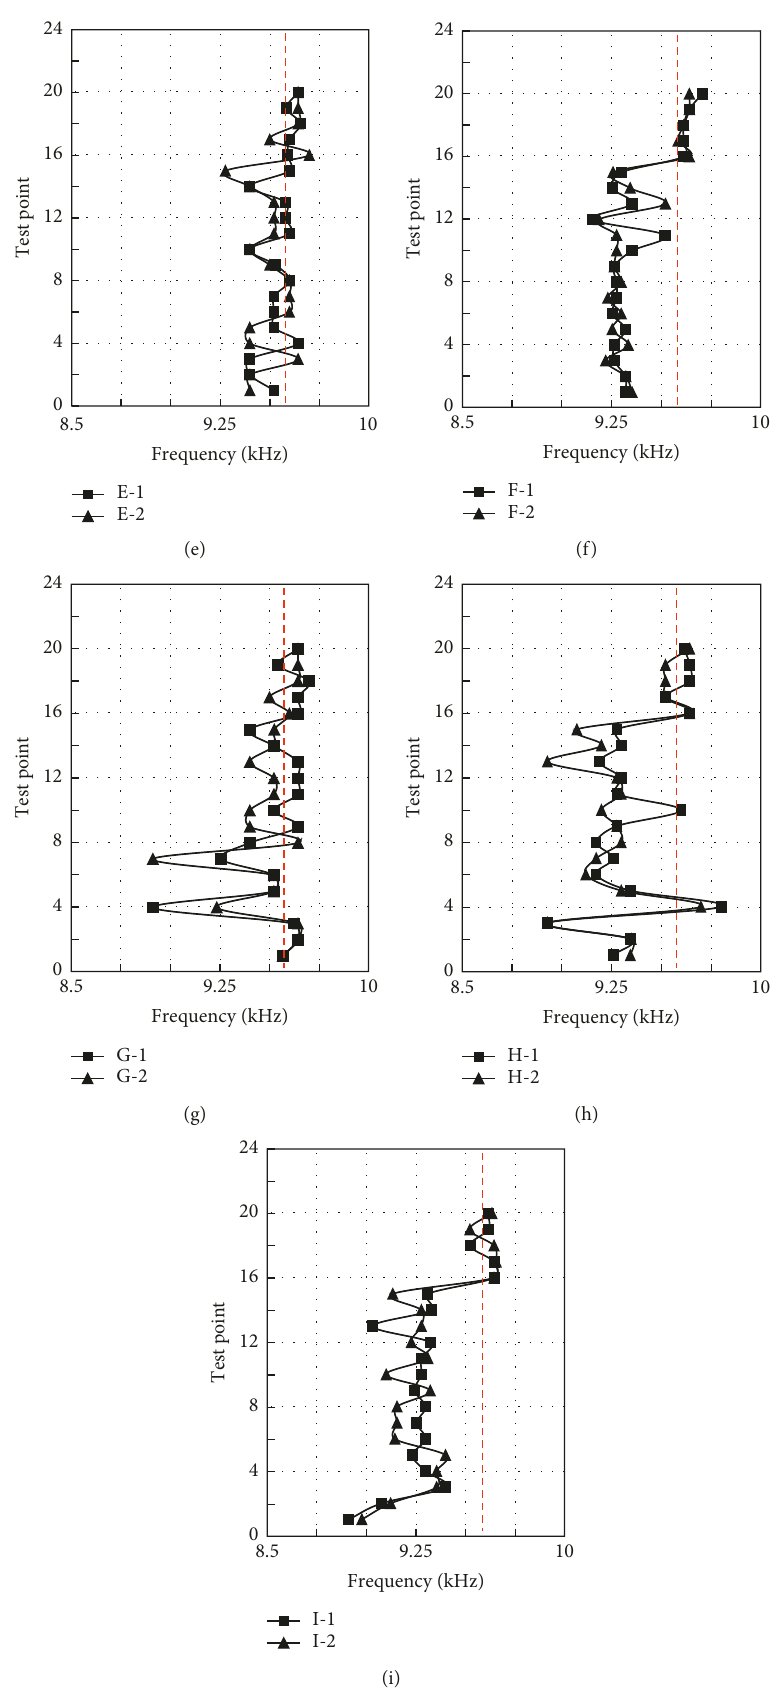
Figure 9: Test results of all holes in the specimen. (a) Hole A (solid). (b) Hole B (solid). (c) Hole C (empty). (d) Hole D (10%-solid). (e) Hole E (20%-solid). (f) Hole F (30%-solid). (g) Hole G (10%). (h) Hole H (20%). (i) Hole I